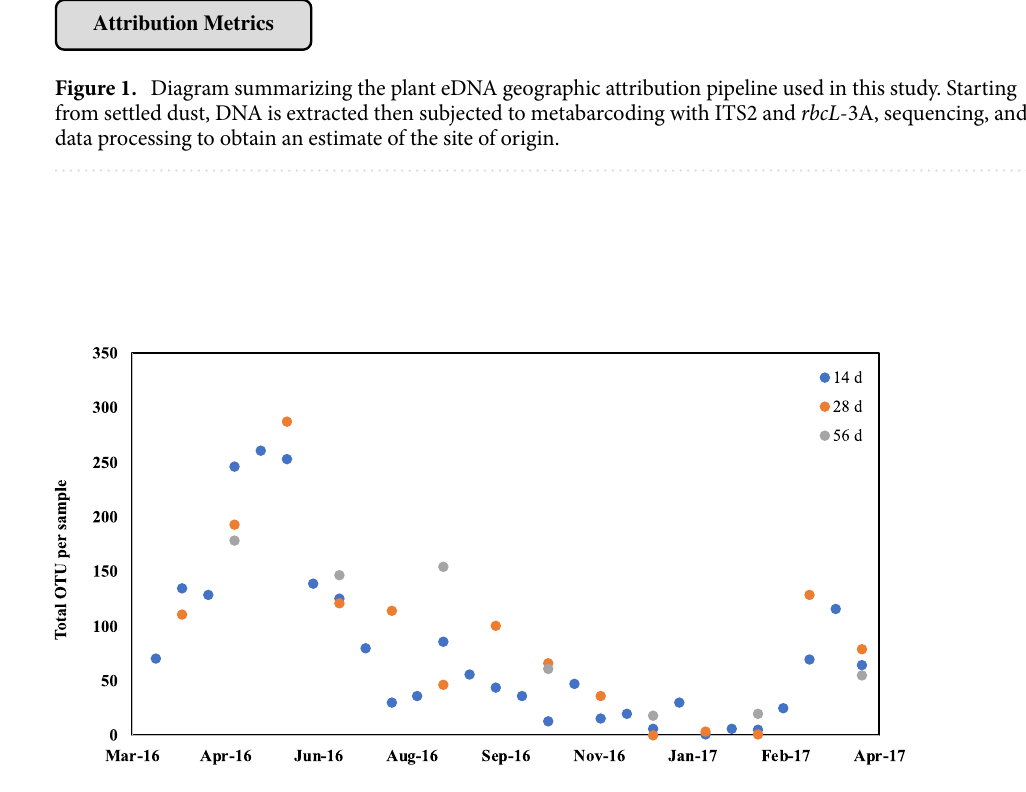
Figure 2. Number of total OTU per sample generated with ITS2 and rbcL -3A minibarcodes from dust samples collected in Lexington, MA. Samples were collected on the date indicated after 14 (blue), 28 (orange), or 56 (gray) days of environmental exposure prior to